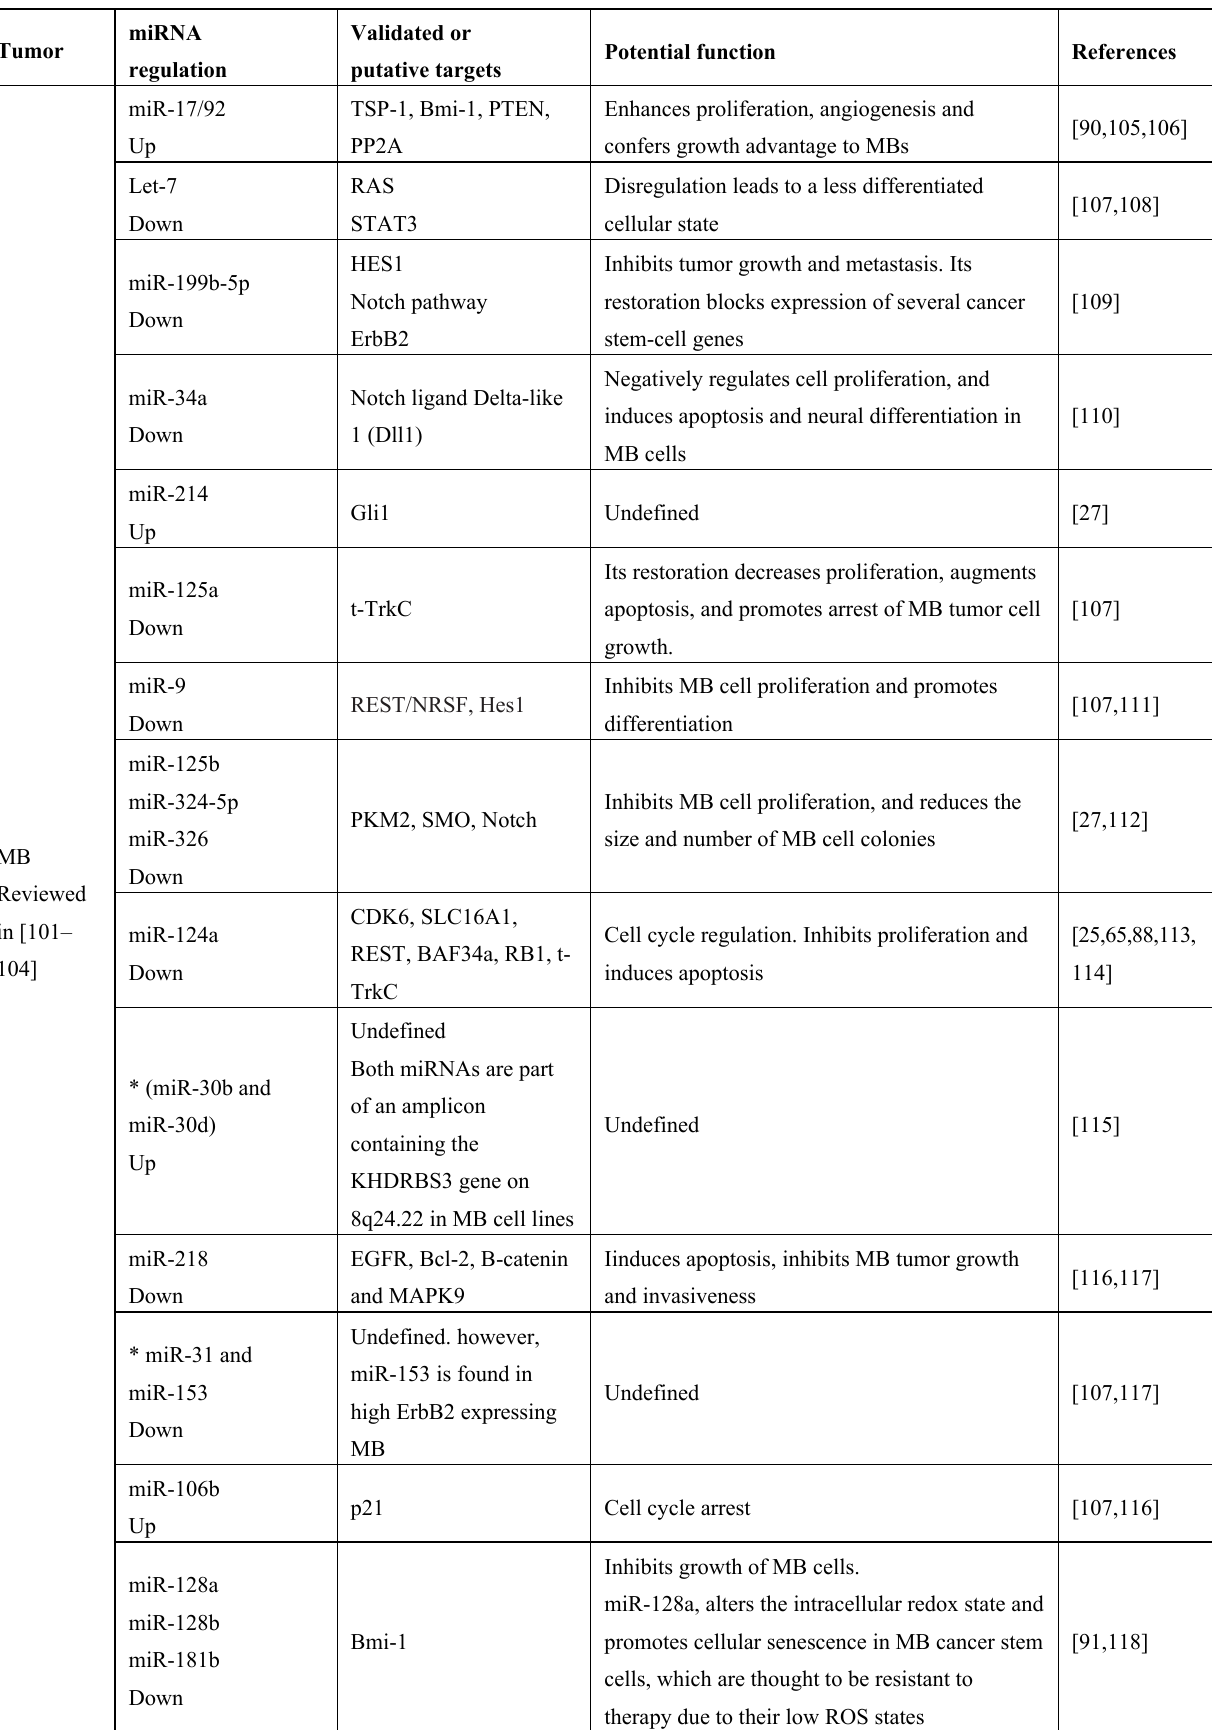
Table 1. Frequently deregulated miRNAs in neuronal embryonal